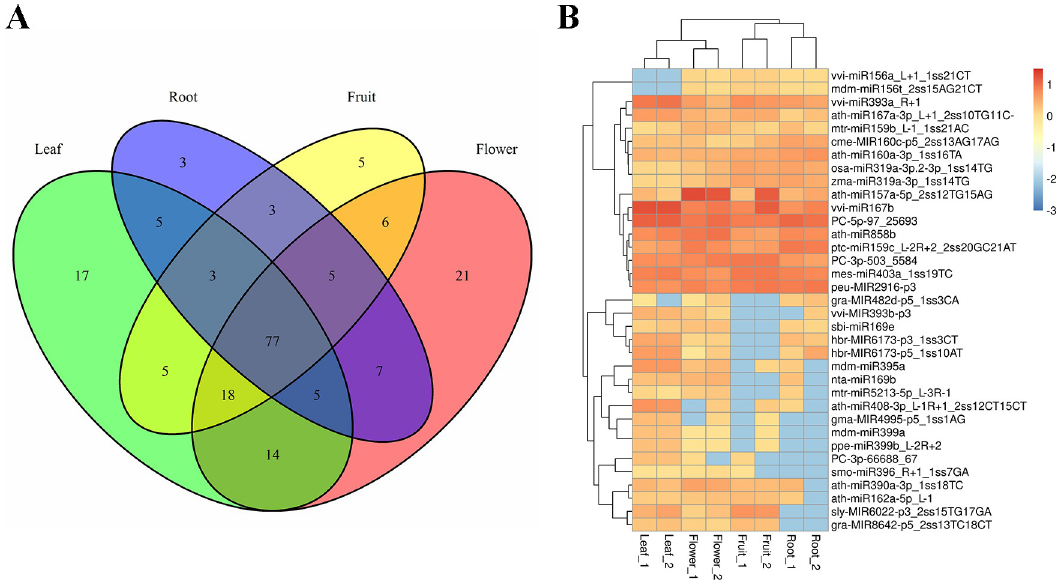
Fig 7. Tissue-specifically expressed miRNAs in Paeonia . (A The spatial expressing patterns of the miRNAs in four different tissues of Paeonia , B Differential expressing levels of miRNAs in four different tissues of Paeonia